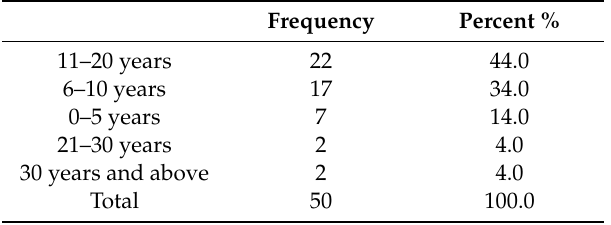
Table 1. Distribution of respondents by number of years of experience.